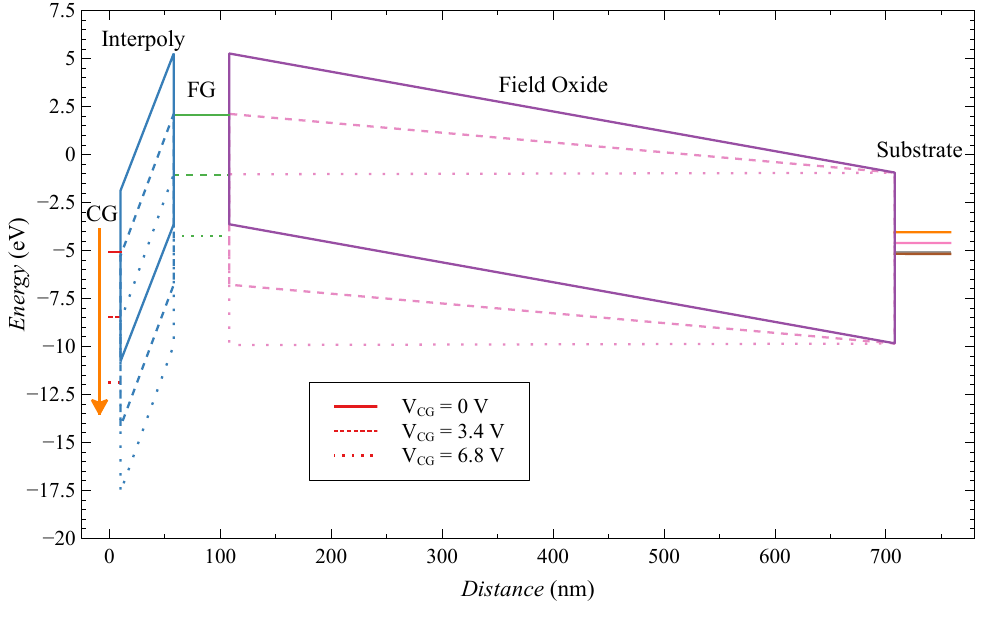
Figure 24. Energy band diagram of EPAD structure.